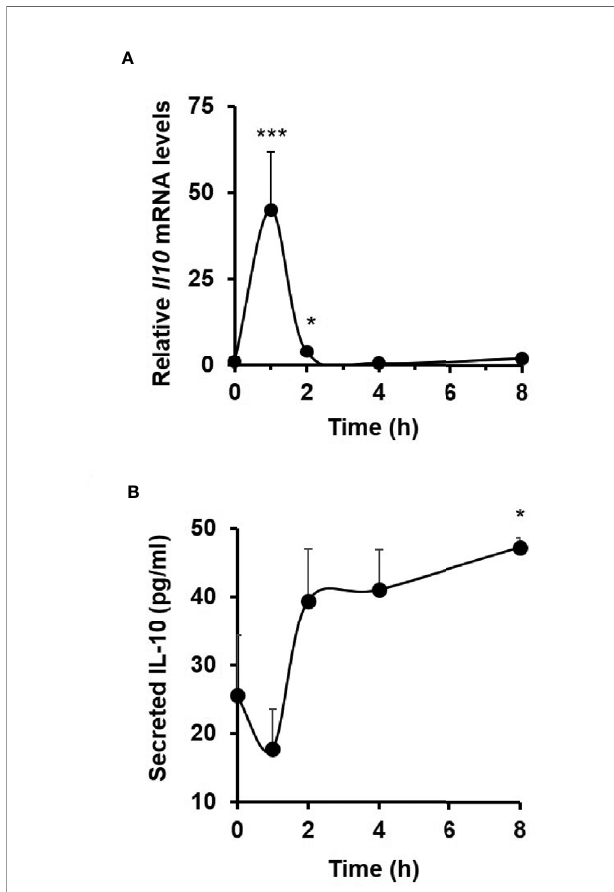
FIGURE 5 | TNF induces interleukin 10 expression and release from C57BL/ 6J enteroids. Analysis of (A) Il10 mRNA (measured by qPCR) and (B) IL10 protein (measured by ELISA) in resting and 40 ng/ml TNF-treated enteroid cultures from C57BL/6J mice. Signi fi cant differences compared to untreated controls, * p < 0.05 and *** p < 0.001; Kruskal – Wallis test. Data is presented as mean ± SEM; N = 6